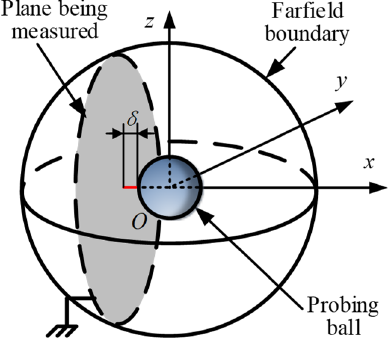
Figure 2. Model for analysis.